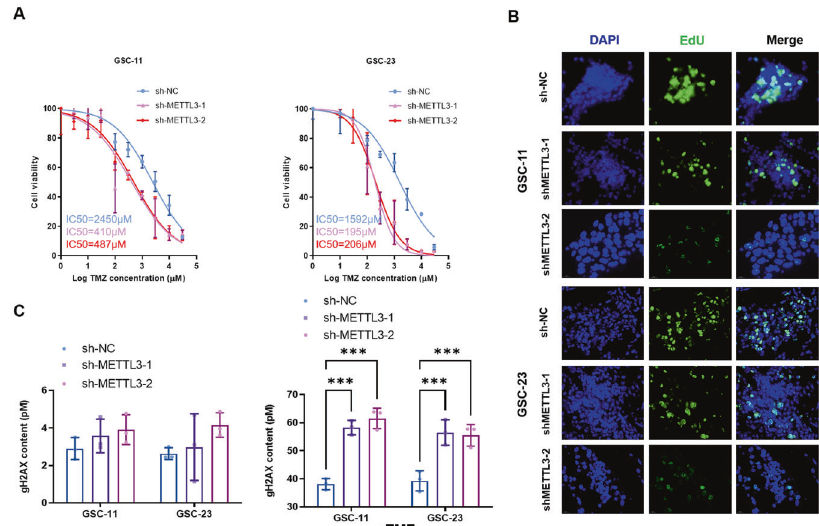
Fig. 3 METTL3 knockdown in GSCs not only improved TMZ sensitivity of GSCs, but also elevated TMZ-induced DNA damage. A The effect of METTL3 knockdown (shMETTL3-1 and shMETTL3-2) on TMZ IC50 value of GSCs (GSC-11 and GSC-23) was analyzed by CCK-8 assay. B Edu assay was applied to evaluate the effect of METTL3 knockdown (shMETTL3-1 and shMETTL3-2) on proliferation ability of GSCs (GSC-11 and GSC-23). C The level of γ H2AX content was analyzed with ELISA to evaluate DNA damage extent of GSCs (GSC-11 and GSC-23) after TMZ administration. *** P < 0.001 versus indicated